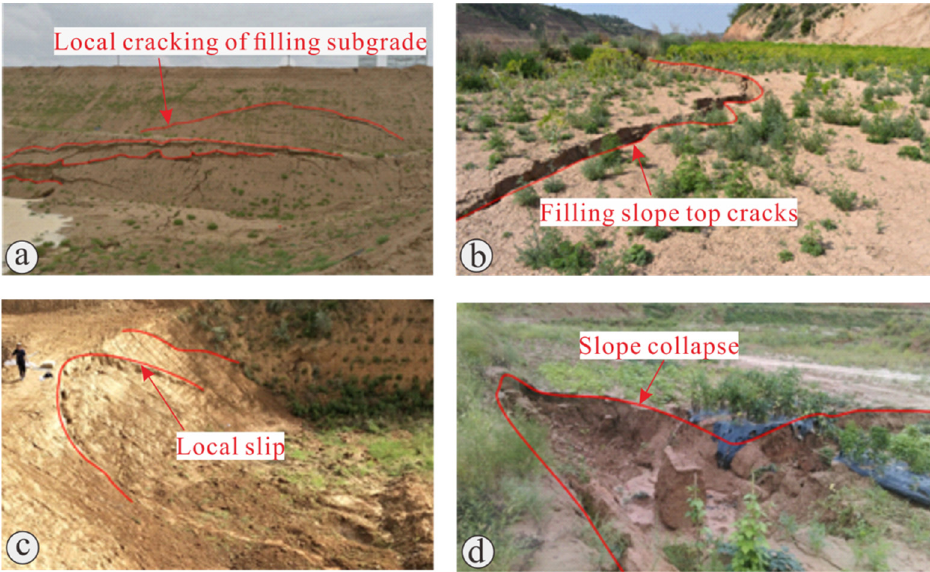
Figure 1. Loess filling slope disaster. ( a ) Local cracking of filling subgrade, ( b ) filling slope top cracks, ( c ) local slip of fill slope and ( d ) collapse of channel fill slope.